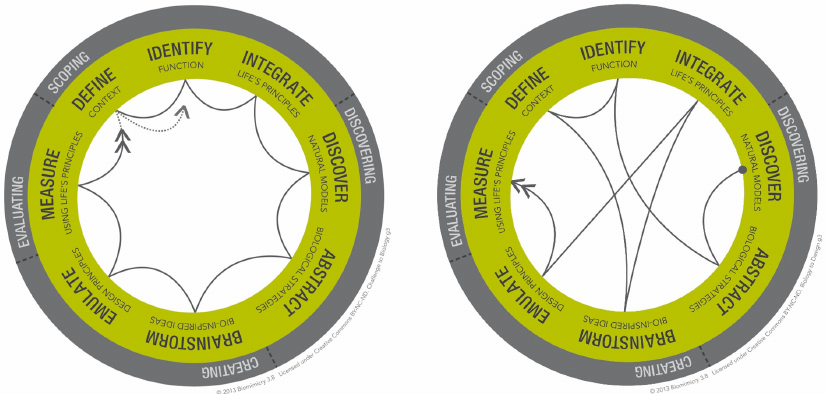
Figure 19. Biomimicry thinking methodology, as proposed in [76], showing the “challenge to biology” method on the left and the “biology to design” method on the right. Attribution: Biomimicry 3.8, creative commons BY-NC-ND. Designs 2018 , 2 , x FOR PEER REVIEW